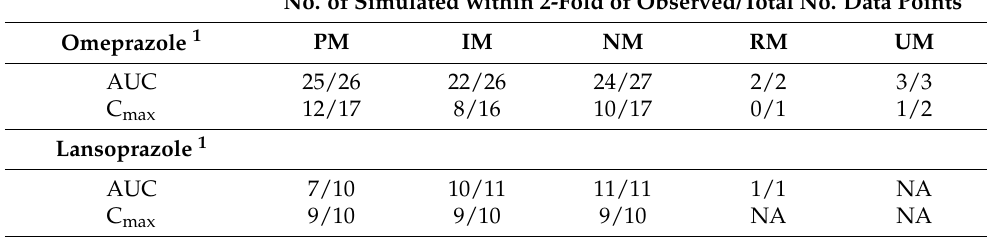
Table 2. Summary of Simulated versus Observed AUC and C max Means Across CYP2C19 Phenotypes for Omeprazole and Lansoprazole.